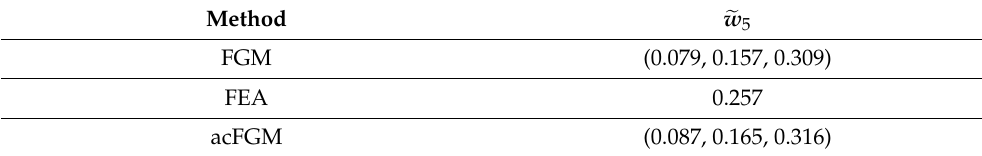
Table 12. Fuzzy priorities of criterion (cid:101) w 5 derived by decision maker #1 using various